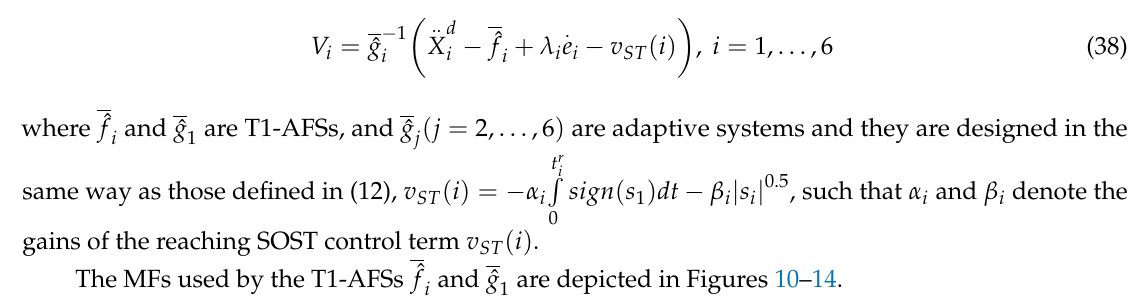
Figure 10. Membership functions used by 1